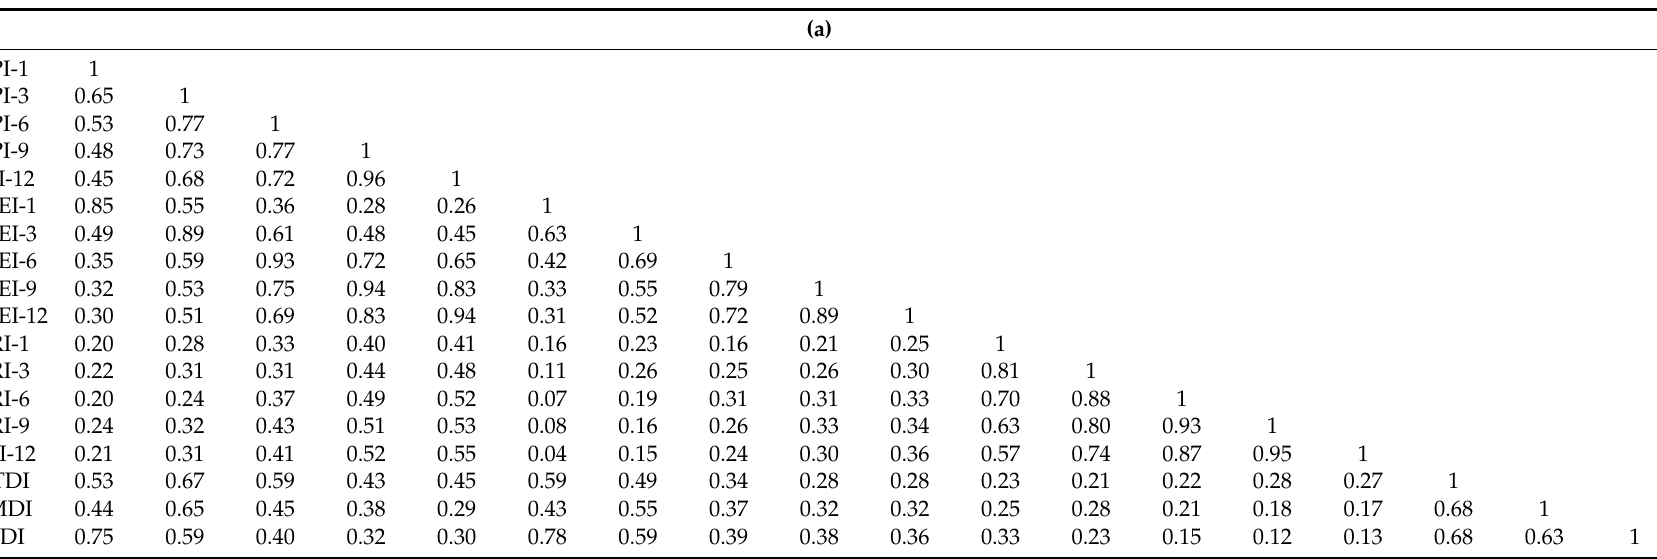
Table 6. The Pearson’s correlation coefficient matrix computed between the paired values of the drought indices at multiple time scales for (a) Gondar station and (b) Debremarkos station. The SRI used in the cases are calculated using flow records at Bahirdar station and Debremarkos station